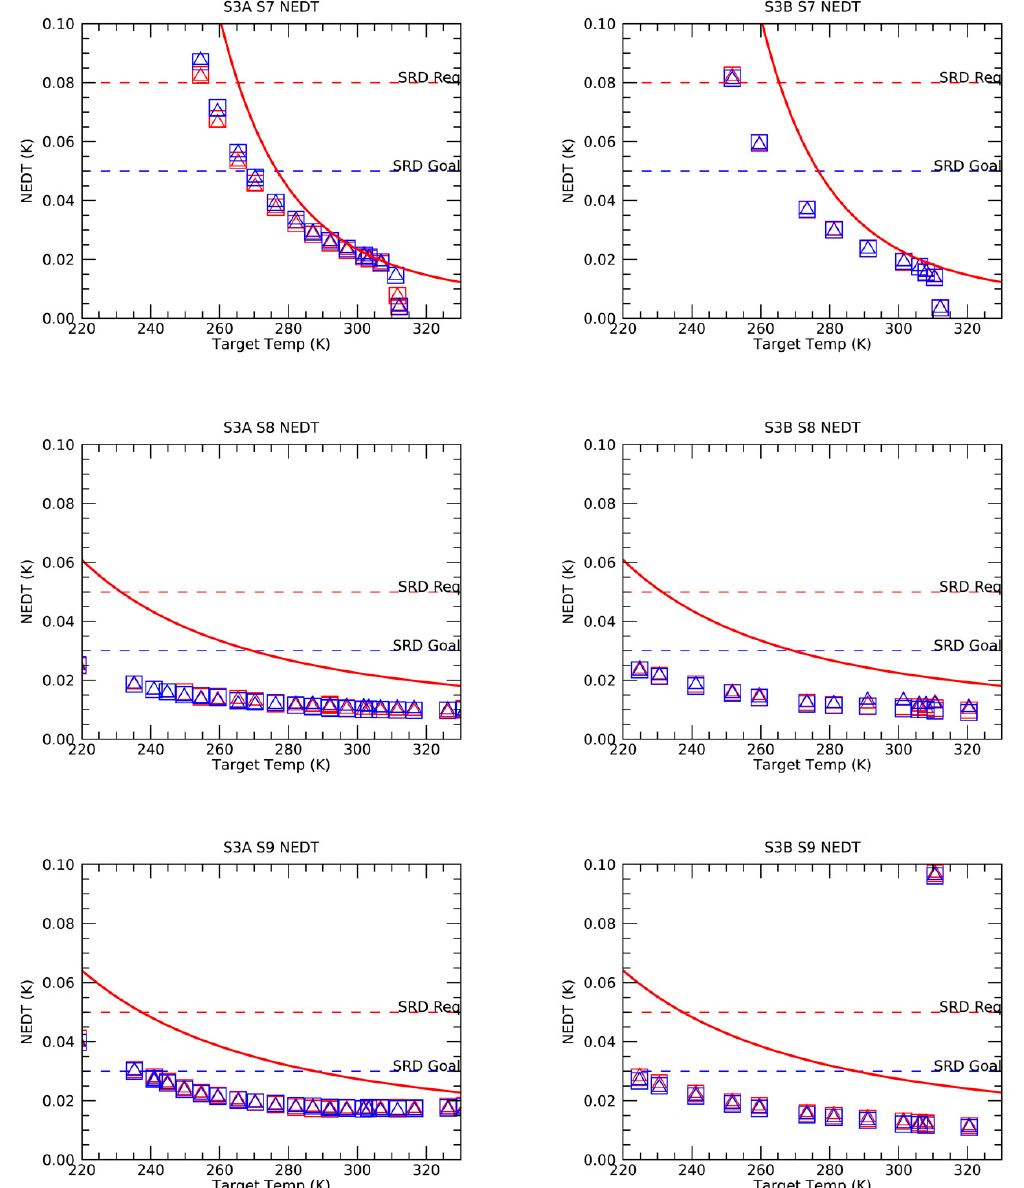
Figure 7. SLSTR-A (left) and SLSTR-B (right) nadir view measured Noise Equivalent Difference Temperature (NEDT) vs. brightness temperatures for channels S7–S9. The values for the oblique view are not shown as they are very close to the values for the nadir view. ☐ = Detector 1, Integrator 1; ☐ = Detector 1, Integrator 2; Δ = Detector 2, Integrator 1; Δ = Detector 2, Integrator 2. The red curve corresponds to the predicted values, and the dashed red line shows the System Requirements Definition (SRD) target requirements.